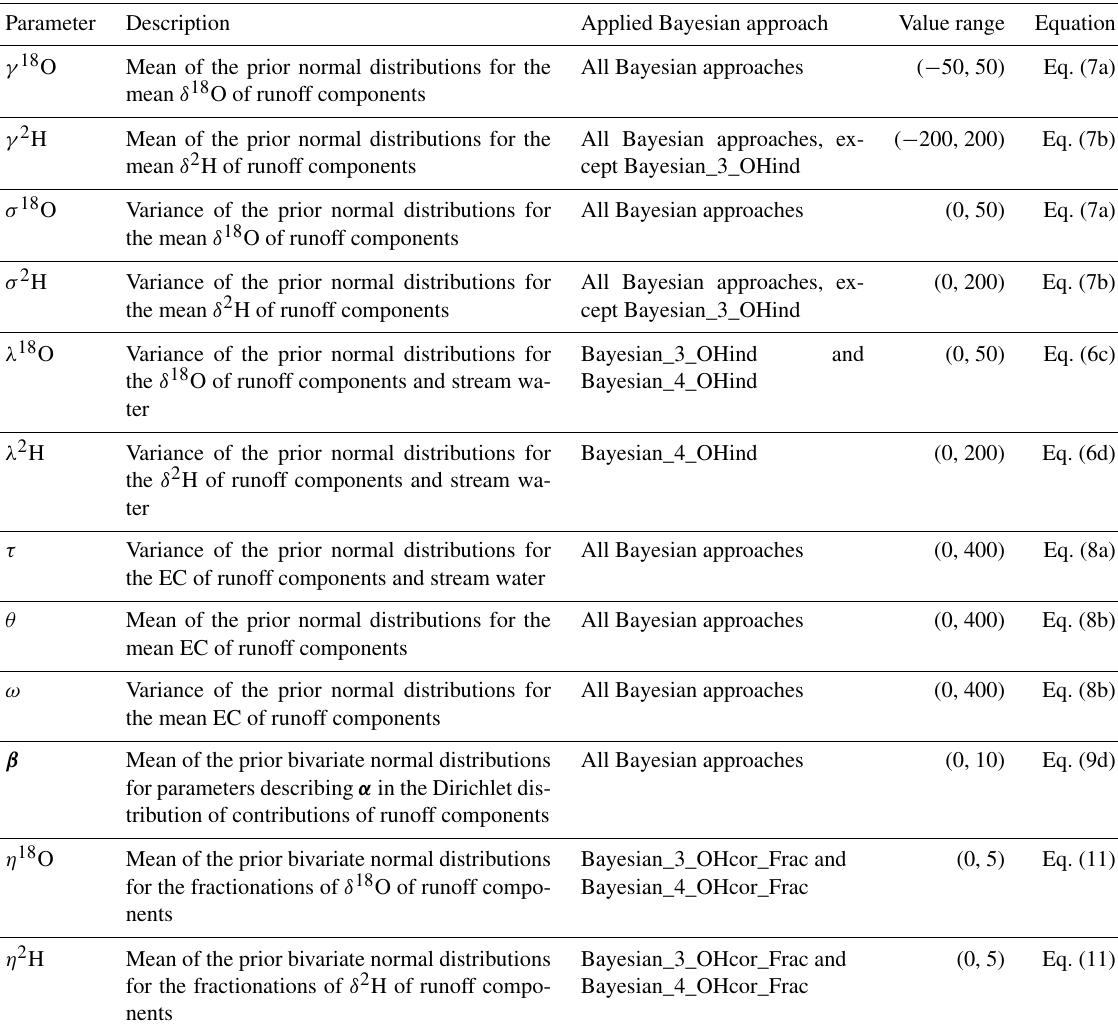
Table 3. Parameters used for prior distributions in the Bayesian